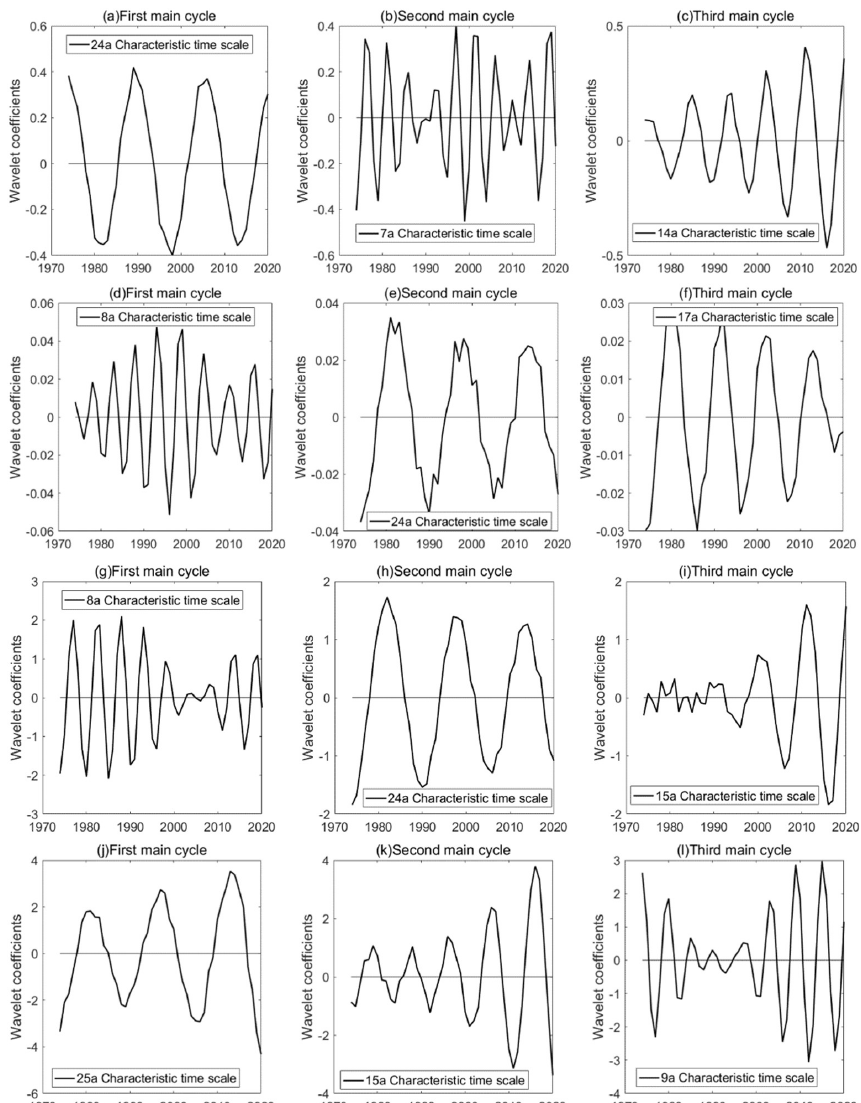
Figure 10. Time-scale variation. ( a – c ) precipitation; ( d – f ) sea surface heat flux; ( g – i ) total cloud cover; ( j – l ) long-wave radiation. 24a represents 24 years, and the others are the same.